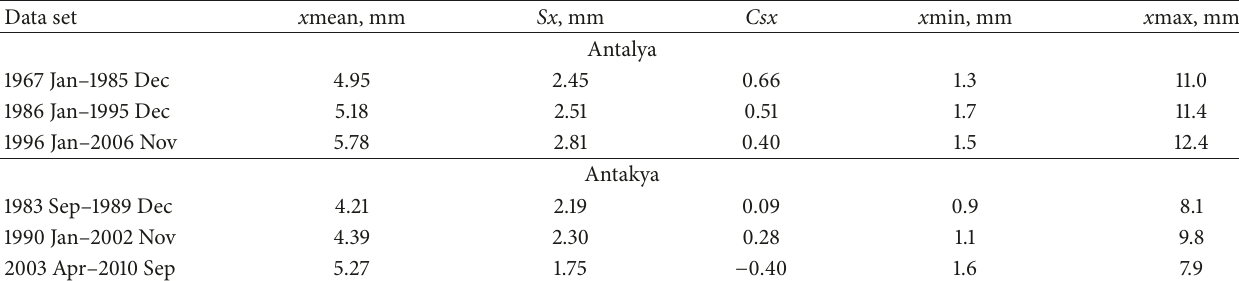
Table 1: The monthly statistical parameters of pan evaporation data